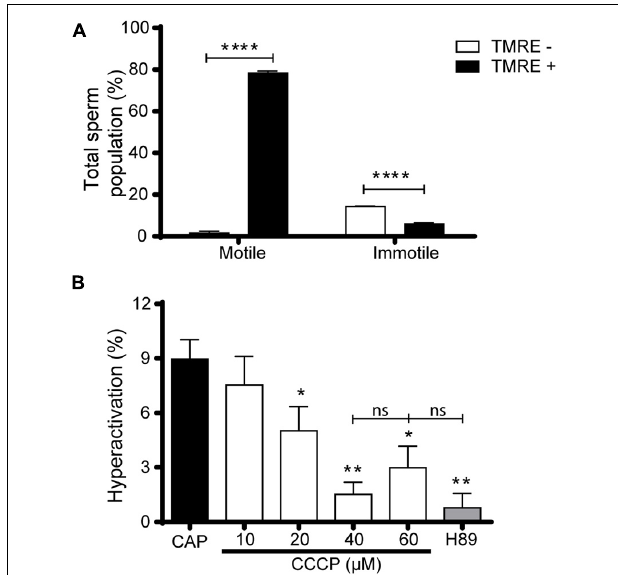
FIGURE 4 | Association between the increase in mitochondrial activity and motility in mouse sperm. (A) Epididymal sperm were incubated under capacitating conditions, loaded with TMRE, and motility as well as TMRE staining were simultaneously analyzed by microscopy to calculate the percentage of motile and immotile sperm with or without TMRE signal (TMRE+ and TMRE-, respectively). n = 3 (B) Epididymal sperm were incubated in the capacitation medium containing CCCP (10–60 µ M), or H89 (20 µ M) or DMSO (capacitated sperm, CAP), and the percentage of hyperactivation in motile sperm determined by CASA. At least 4 independent experiments were performed. In all cases, results are expressed as mean ± SEM; * p < 0.05, ** p < 0.01, **** p <